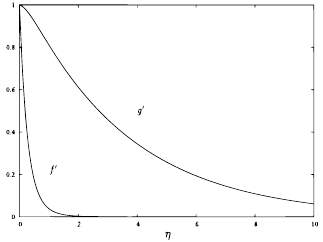
Figure 9. Permeable surface, S (cid:54) = 0: profile plots of f (cid:48) and g (cid:48) against η for the upper branch solution for S = 3 . 77 with γ = − 1 . 0 obtained from the numerical solution to equations (2.4)–(2.6),